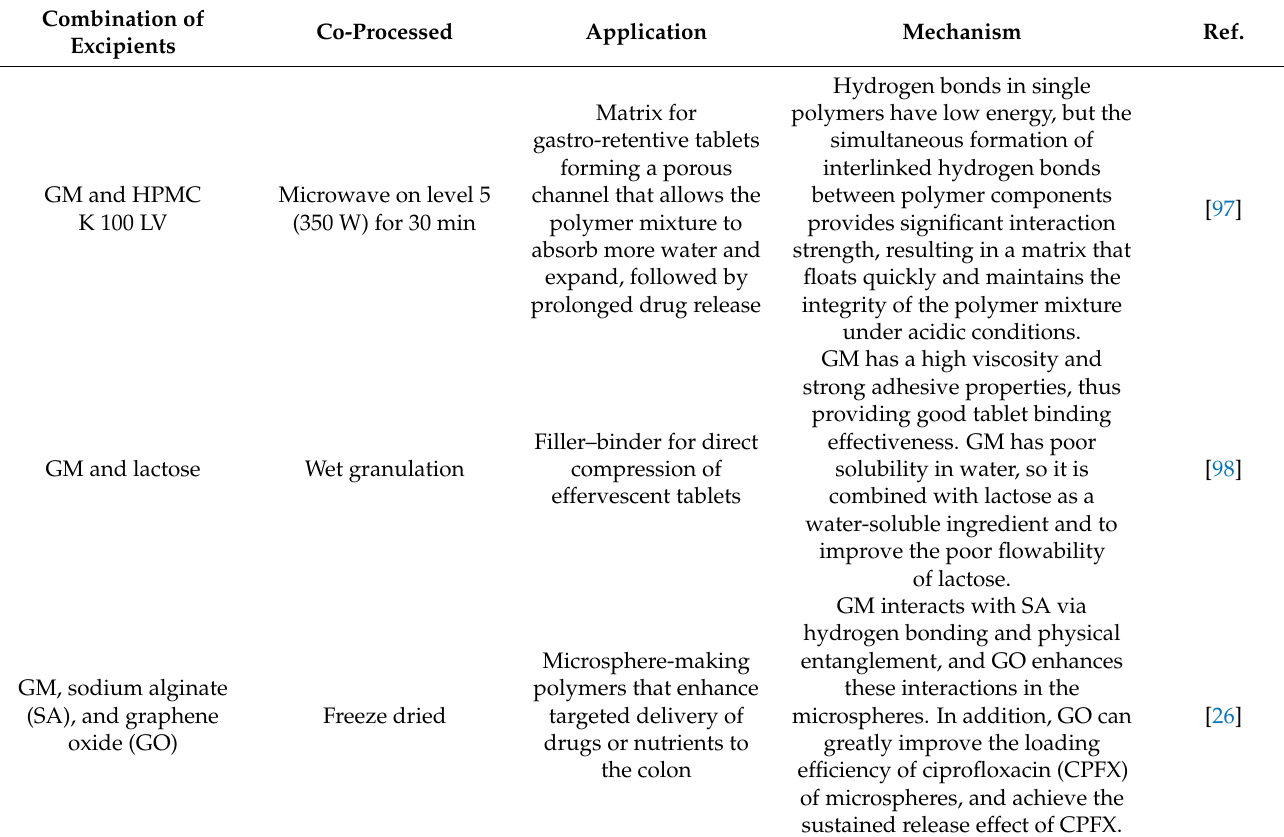
Table 2. Co-processed GM with other